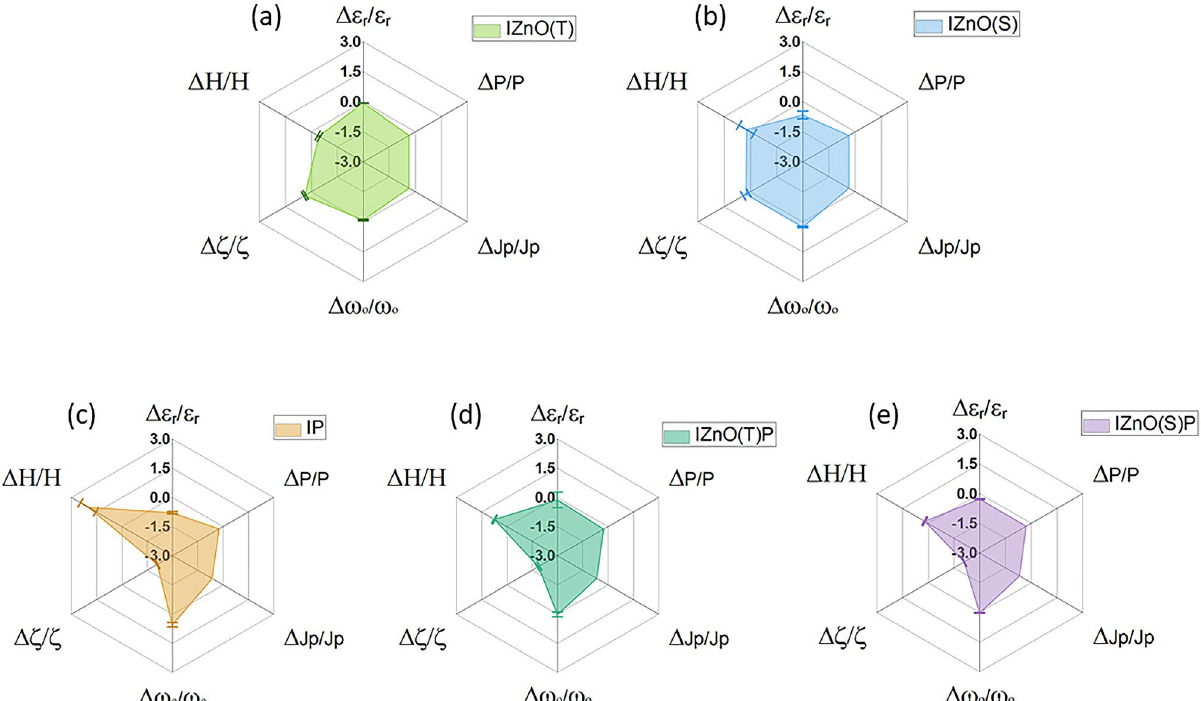
Figure 3. Radar chart of correlation of physical parameters (The abbreviation ε r , P, Jp, ω o , ζ and H are used for physical parameters dielectric constant, dipole moment, polarization current density, mechanical frequency zeta potential and enthalpy), These Y chart values are relative change (with respect to Insulin) for various samples which suggest the deviation from the physical parameter of Insulin. Norman cloture for papain sample P is used here because P is carried with different concentration in these techniques. Here for microwave spectroscopy P1 (Highest concentration) is used and the lower dilutions were used for zeta potential measurement because high concentrations are not suitable in these studies due to turbulence. The detail protocol of sample preparation was discussed in the Supplementary file 1. Although, mixing ratio is same in